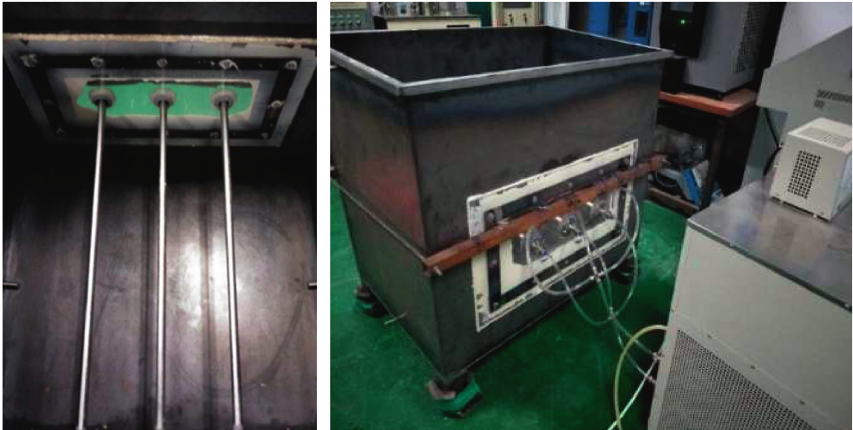
Figure 3: Freezing pipes (a) and physical modelling box (b). Table 2: Experimental parameters in prototype and physical